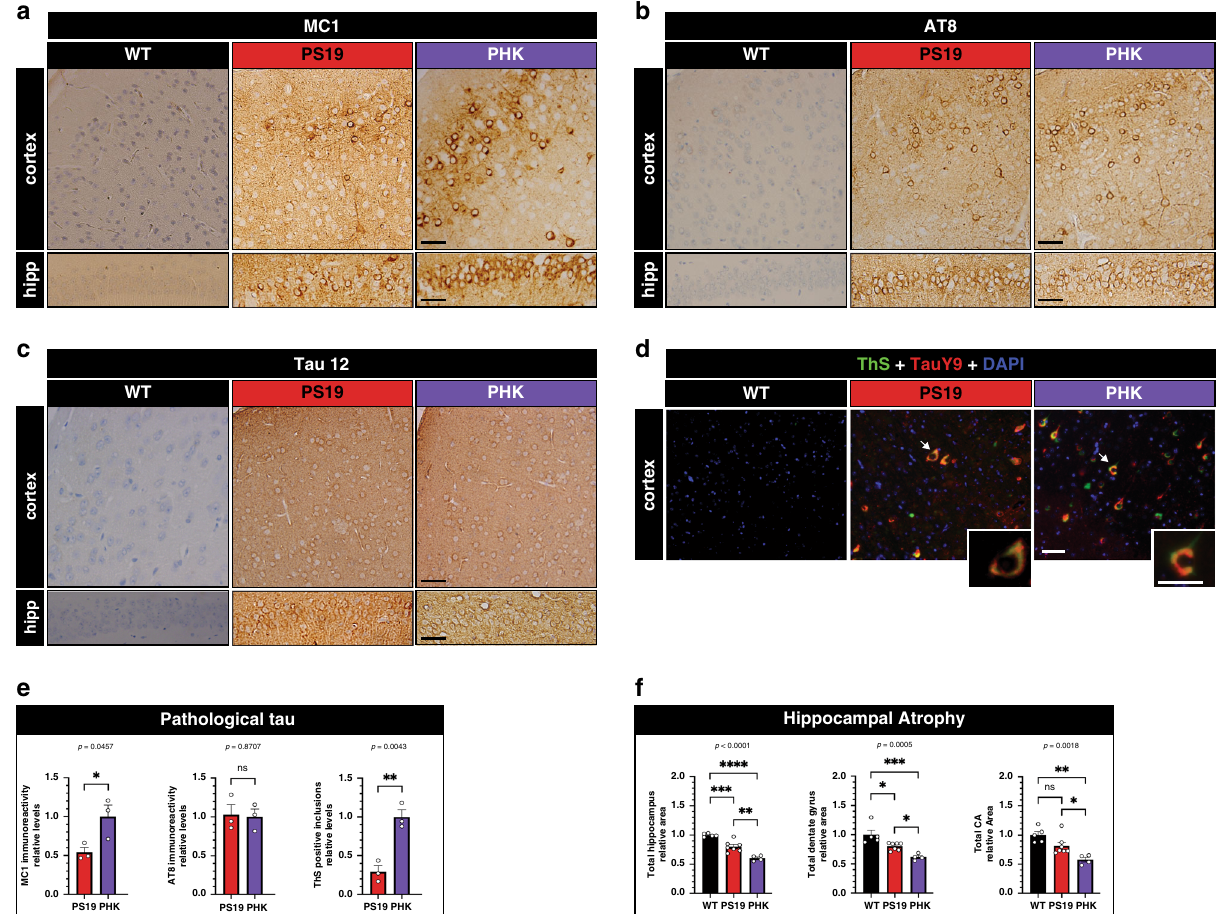
Fig. 6 HDAC6 depletion accelerates tau pathology and neurodegeneration. Representative IHC images of pathological tau detected with the MC1 ( a ), phosphorylated tau (AT8) ( b ), and total tau (Tau 12) ( c ) antibodies in the cortex (top panels) and hippocampus (bottom panels) of 12-month old WT, PS19, and PHK mice. Representative images are shown from n = 3 mice per genotype. Scale bar = 50 μ m ( a – c , scale bar is identical for both hippocampus and cortex). d ThS-positive tau pathology (green) is double-labeled with total tau (TAUY9, red) and DAPI (blue) to highlight cortical amyloid burden. The high magni fi cation inset depicts a neuron with robust tau pathology. e Quanti fi cation of MC1 and AT8 immunoreactivity in the hippocampus and ThS- positive inclusions in the cortex ( n = 3 mice per genotype). Error bars represent means ± SEM. Statistical analysis was performed using two-sided unpaired t -test and normalized to PHK. f Quanti fi cation of hippocampal area using total hippocampus, dentate gyrus, and CA brain area from 12-month-old mice ( n = 4 mice per genotype). Measurements were performed in an unbiased manner using ImageJ software. Statistical tests: one-way ANOVAs were performed with Tukey ’ s test for multiple comparisons among groups. Data shown represent means ± SEM normalized to WT. * p < 0.05; ** p < 0.01; *** p < 0.001; **** p < 0.0001. Source data are provided as a Source Data